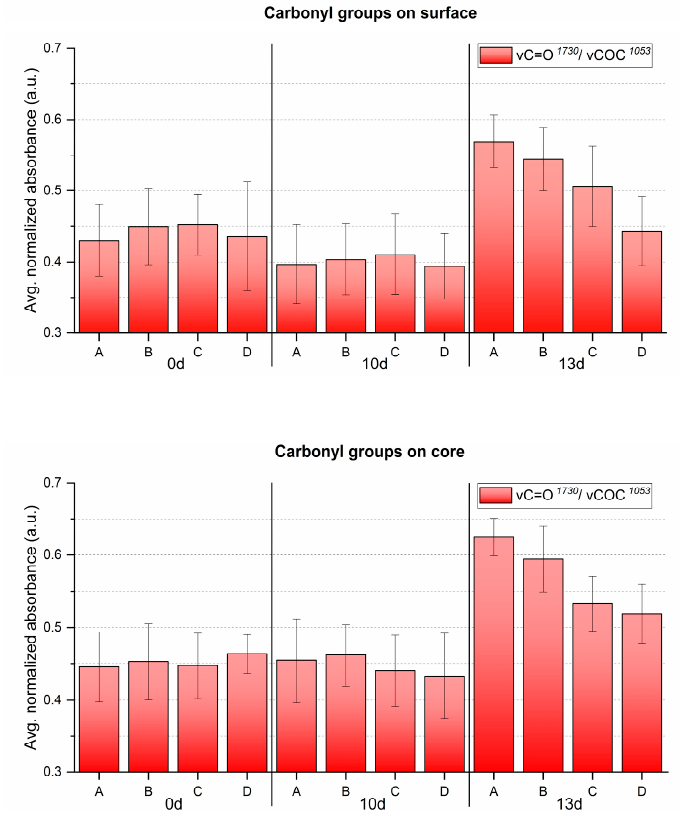
Figure 9. Averaged and normalized ATR-FTIR absorbance for C=O groups of the artificially aged celluloid sheets. A, B, C and D refer to sampling points. Error bars correspond to the SD.